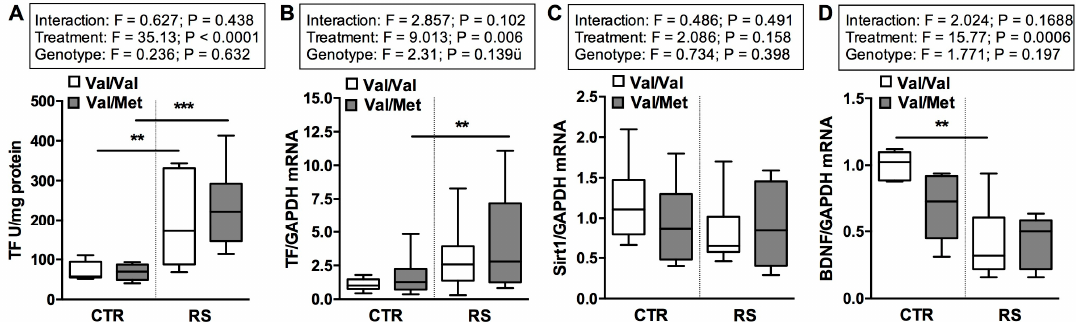
Figure 6. Impact of restraint stress on Tissue Factor, BDNF and Sirt1 expression in arterial tissue. ( A ) Tissue Factor (TF) activity and ( B ) TF, ( C ) Sirt1, ( D ) BDNF mRNA levels in arterial tissue of stressed (RS) and not stressed (CTR) BDNF Val/Val and BDNF Val/Met mice. n = 8 mice/group. Two-way ANOVA followed by Bonferroni post hoc analysis, p values were obtained by using log-transformed variables. ** p < 0.01, and *** p < 0.005. For each box-plot, the center line illustrates the median and box limits indicate the 25th and 75th percentiles.